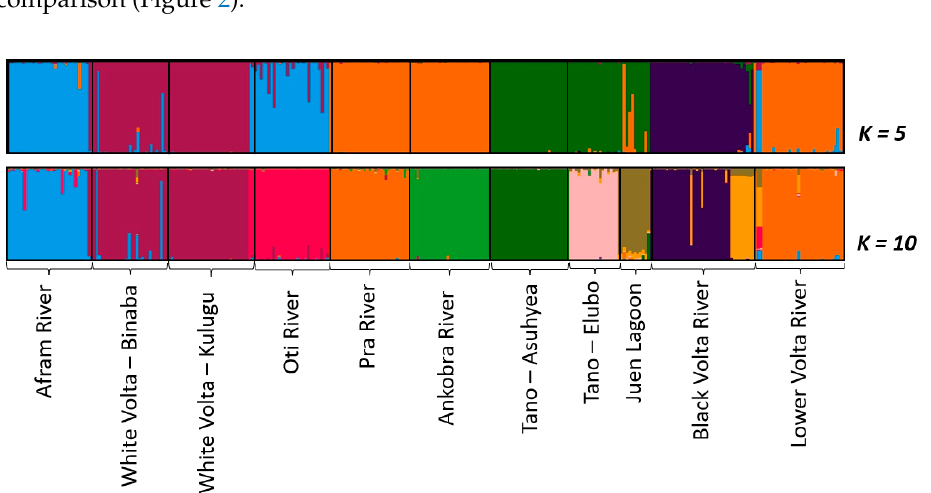
individuals from Juen Lagoon (Q ranged between 0.14 and 0.20).